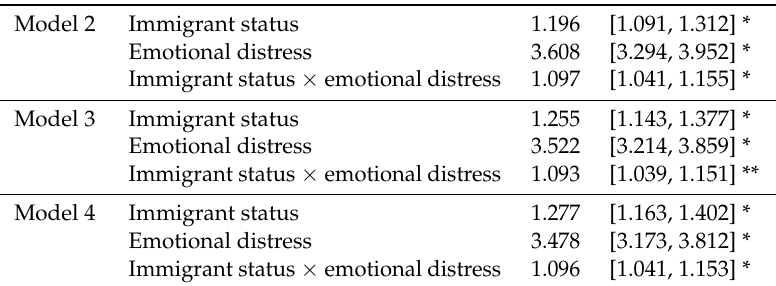
Model 1: unadjusted; Model 1a: unadjusted with interaction; Model 2: adjusted for age and sex (weighted); Model 3: adjusted for patient characteristics (model 2 covariates plus weighted covariates: body mass index, marital status, income, children, smoking, alcohol consumption); Model 4: adjusted for comorbidity (model 3 covariates plus weighted covariates: arterial hypertension, heart disease, cancer, diabetes mellitus); OR: odds ratio; 95% CI: 95% confidence interval; * p < 0.001, ** p < 0.05. Table 4. Ordinal logistic regression models: associations between immigration status, emotional distress, and insomnia symptoms (women).